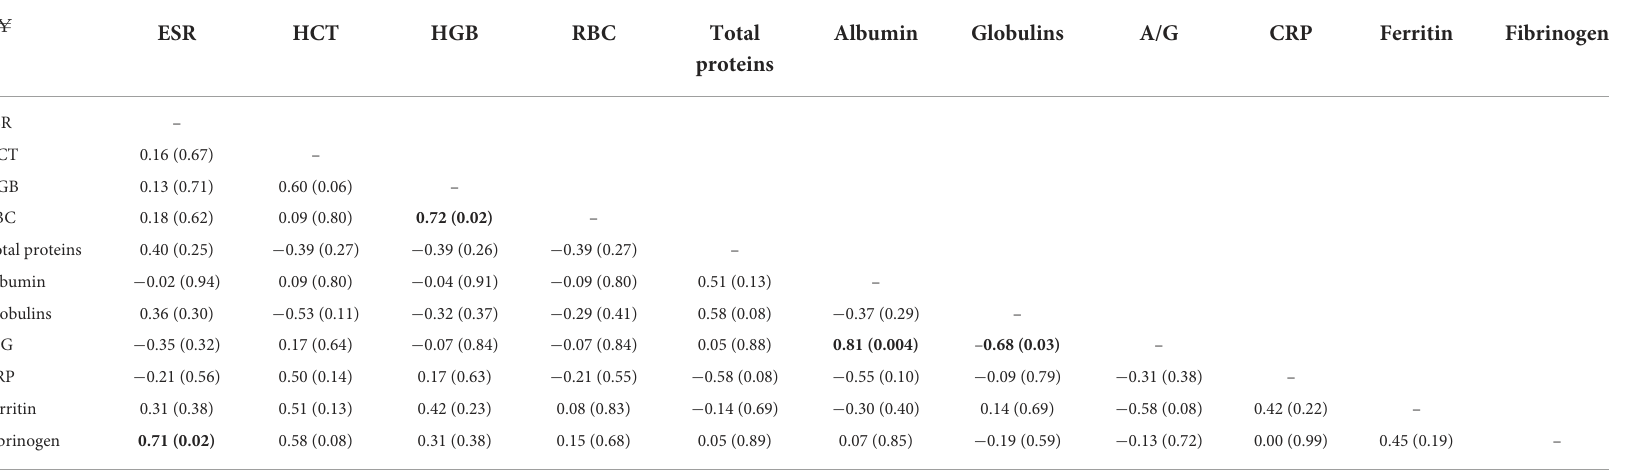
TABLE 4 Correlation matrix between erythrocyte sedimentation rate (ESR), hematocrit (HCT), hemoglobin (HGB), red blood cell count (RBC), albumin/globulin ratio (A/G), C-reactive protein (CRP), ferritin, and fibrinogen in exposed dogs ( n = 10).